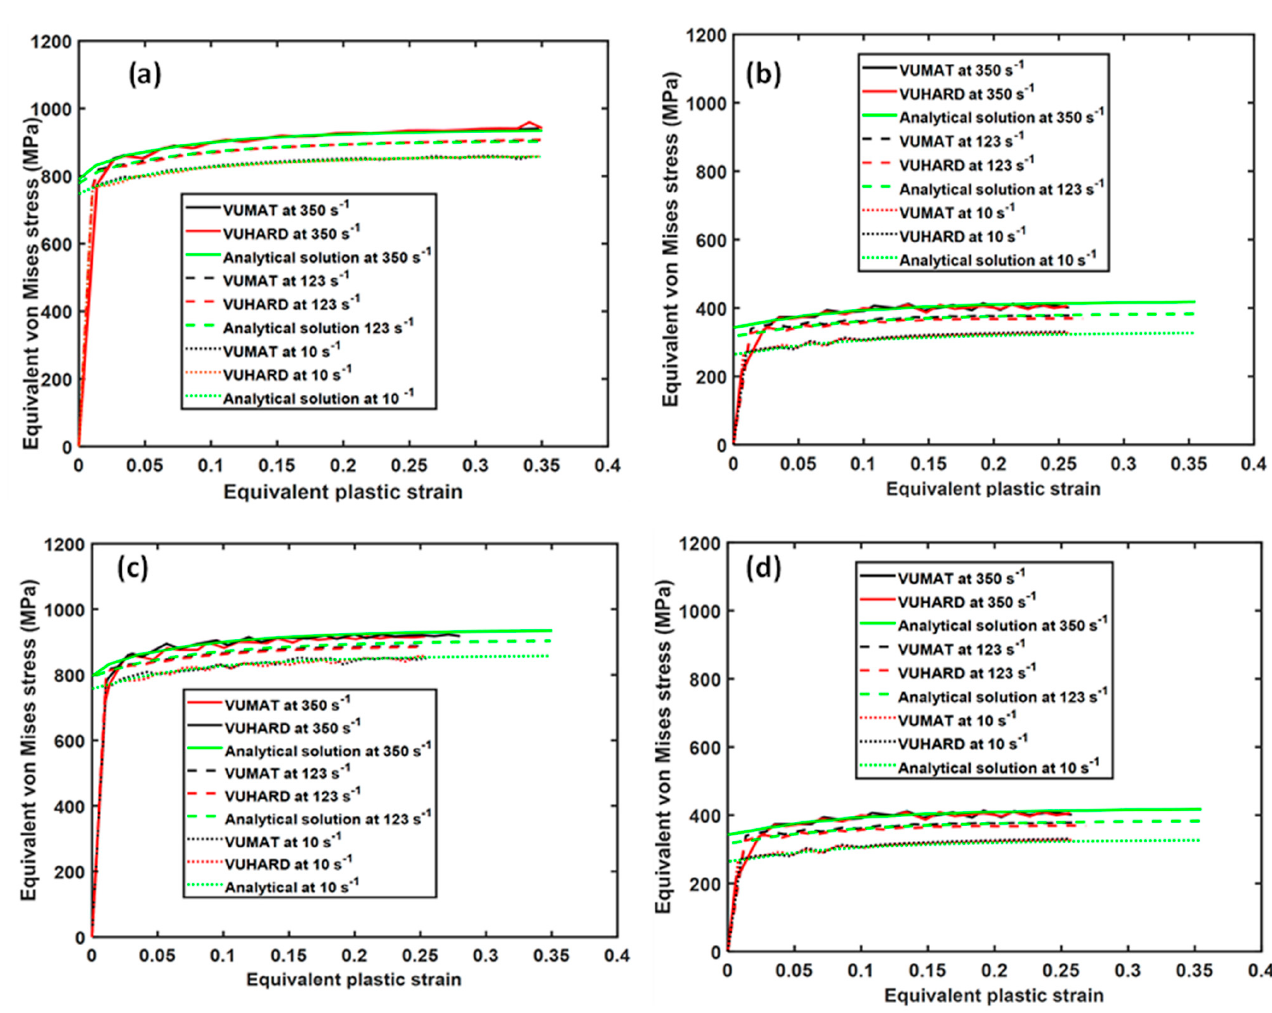
Figure 10. Comparison between the analytical and numerical solutions in VUMAT and VUHARD at three different test velocities and temperatures of ( a,c ) 298 K and ( b , d ) 773 K for an 8-node linear brick element in ( a,b ) compression and ( c , d ) tension for samples D.